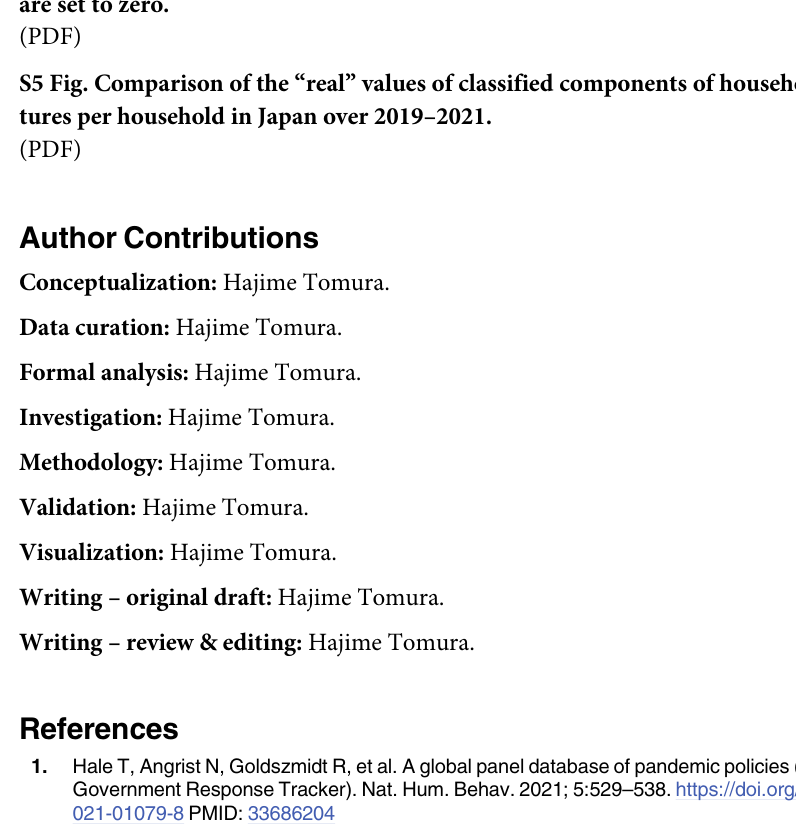
S4 Fig. Fitted values of the regression when time dummies related to states of emergency are set to zero. S5 Fig. Comparison of the “real” values of classified components of household expendi- tures per household in Japan over